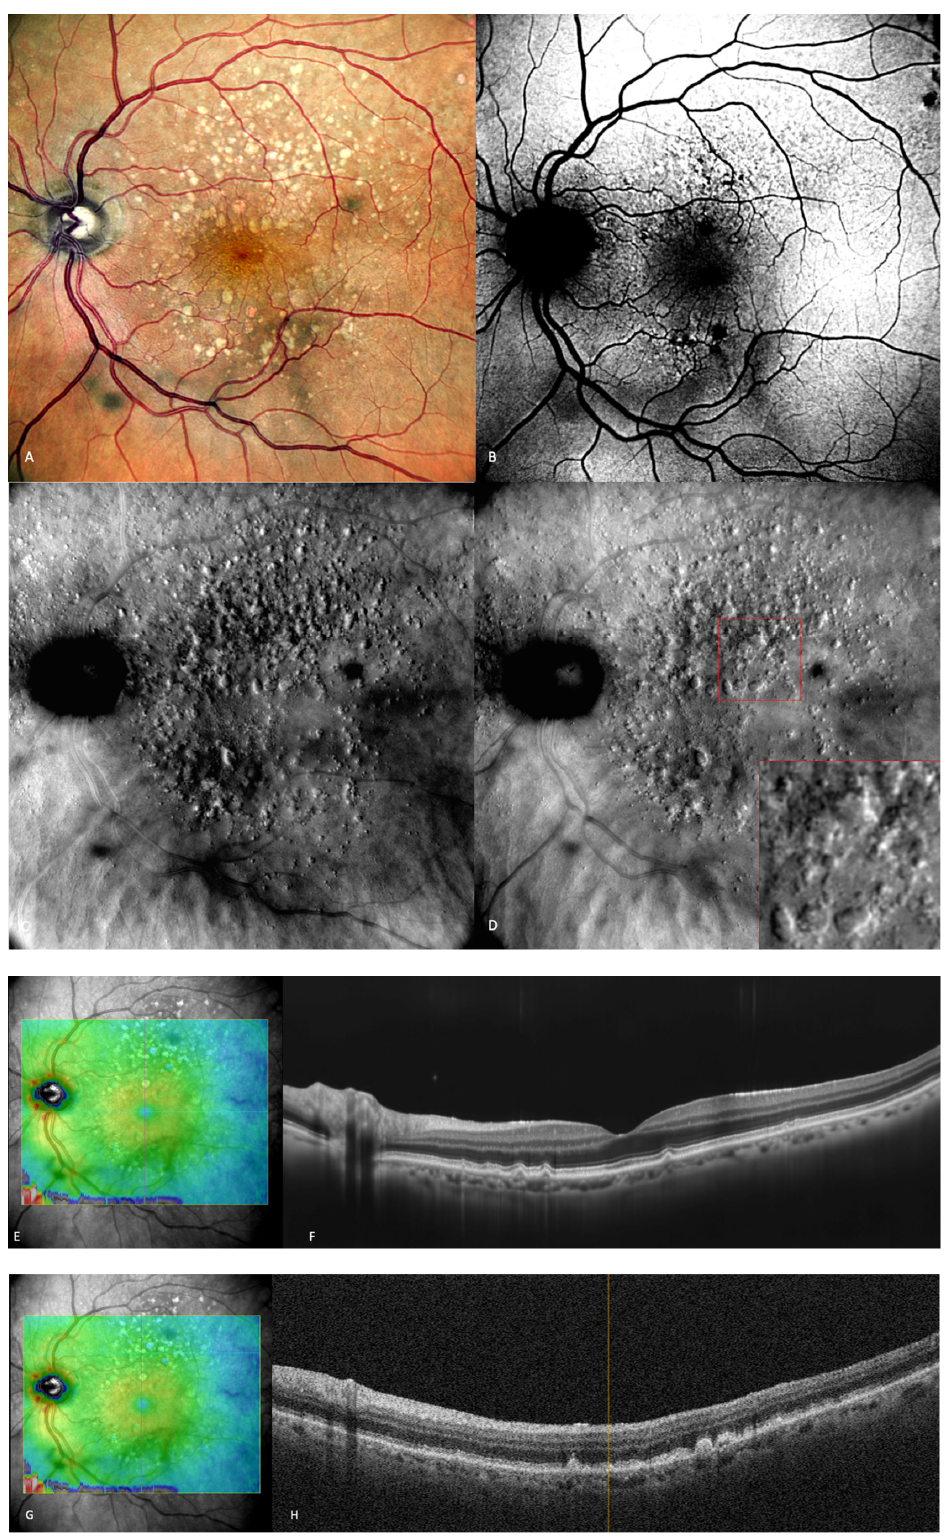
Figure 3. Intermediate AMD. ( A ) Multiple medium and large drusen can be seen on the cSLO image. ( B ) On green FAF, large drusen appear as hyper-autofluorescent patches. ( C ) Retromode deviated right depicting elevated, large drusen. ( D ) Retromode deviated left shows a “moon surface” appearance (zoomed image in the red square). ( E , G ) En-face OCT showing the location of the section in ( F , H ) SD-OCT showing multiple small, medium, and large